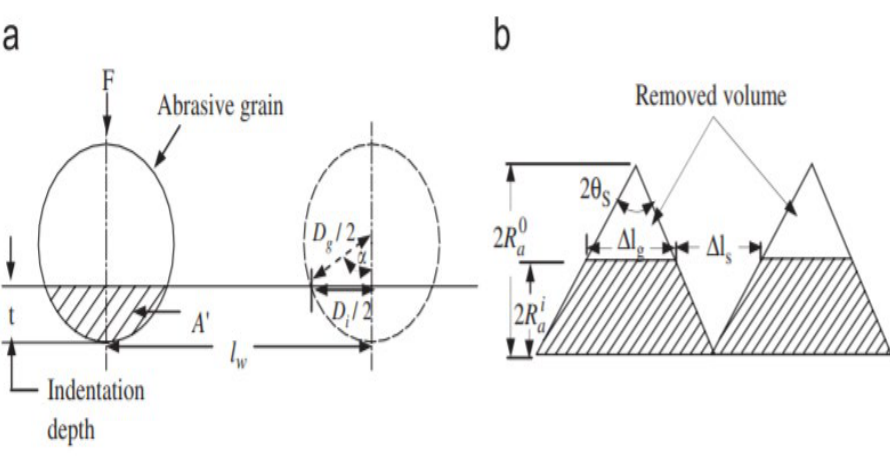
Figure 45. ( a ) spherical abrasive grain removing schematic diagram. ( b ) the surface geometry [246].